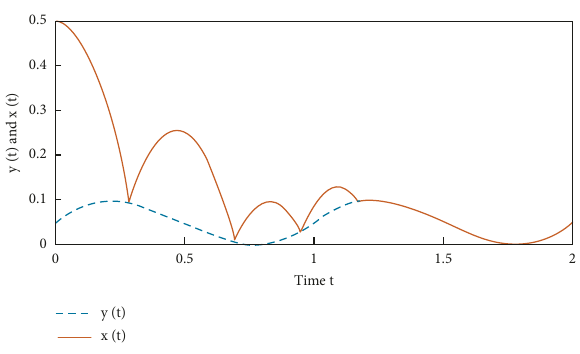
Figure 2: Bouncing ball dynamics